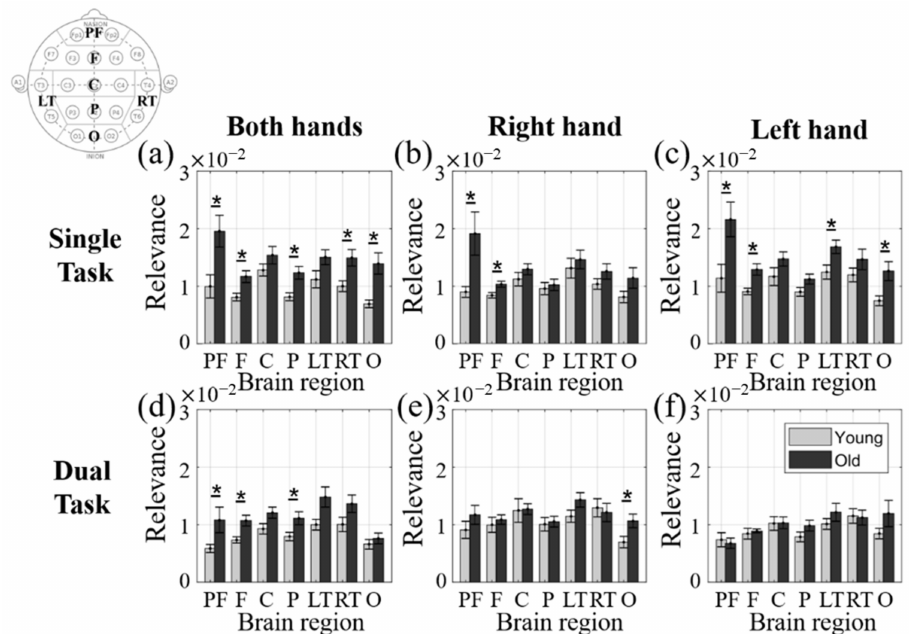
Figure 7. Bar graphs of the relevance values of inter-regional LoFC in ( a ) Single both , ( b ) Single right , ( c ) Single left , ( d ) Dual both , ( e ) Dual right , and ( f ) Dual left . The defined brain regions are presented in the top left corner. Gray- and black-colored bars represent the younger and older groups, respectively. The asterisks indicate the significant differences in the relevance values between the younger and older groups (two-sample t -test, p <